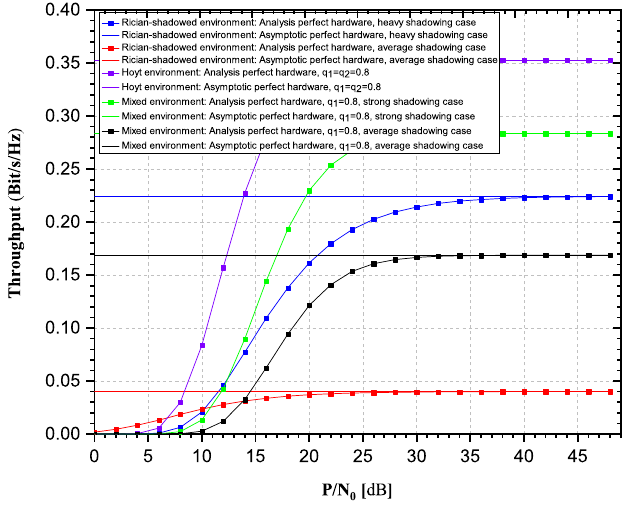
Figure 11. Influence of fading environment: Achievable throughput versus P / N 0